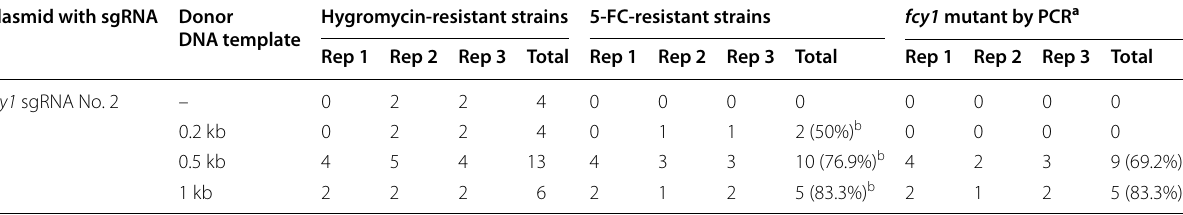
a The number of mutants which can be identified by difference size, or no amplified, bands compared to wild-type control were observed in the genomic PCR experiment (Additional file 1: Fig. S2C) b Percentage of 5-FC-resistant strains from the total number of hygromycin-resistant strains c Percentage of fcy1 mutants from the total number of hygromycin-resistant strains